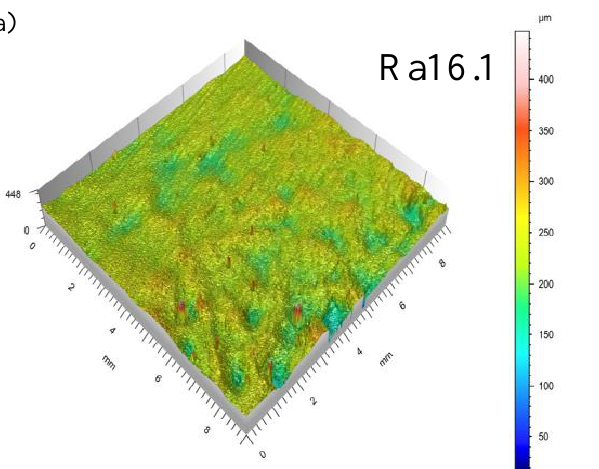
Figure 6. Auxiliary holes and cracks. ( a ) Auxiliary holes; ( b ) Cracks.